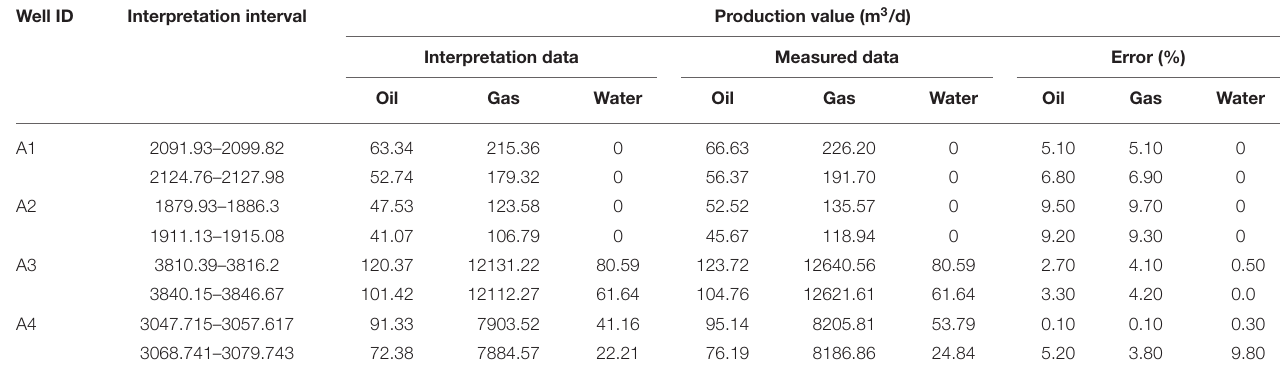
TABLE 3 | Comparison of interpreted wellhead multiphase flow results with measured data. Well ID Interpretation